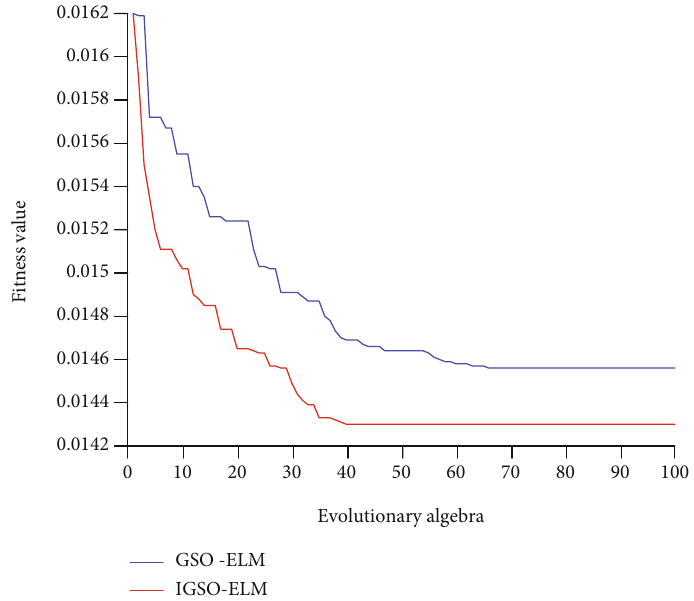
Figure 6: Comparison of the evolution process of IGSO and GSO